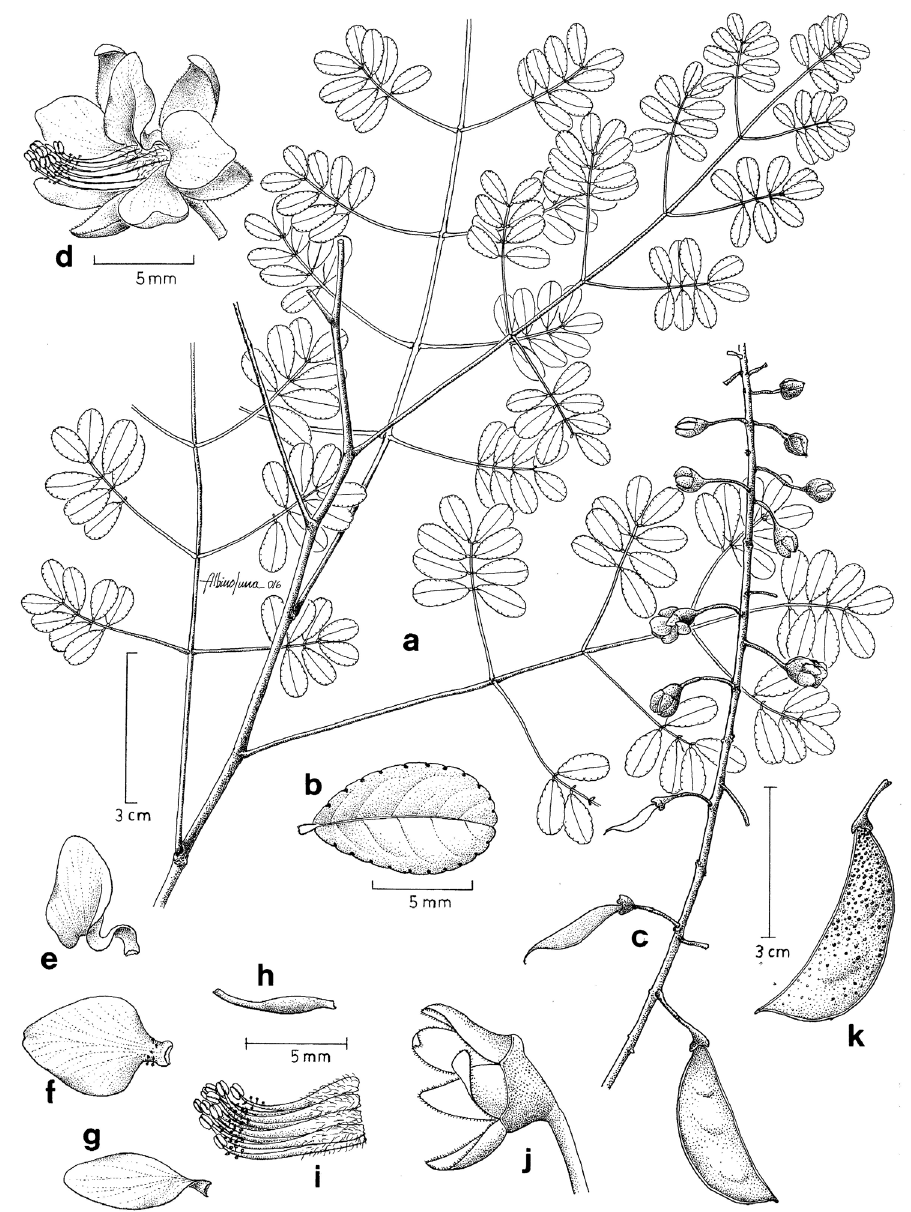
Figure 1. Erythrostemon guevarafeferii, a bipinnate leaves b leaflet upper surface showing marginal glands c inflorescence with immature fruits developing at base d flower e adaxial (median) petal f lateral petal g abaxial petal h gynoecium i stamens j calyx k fruit showing the red stipitate glands as black dots. ( a – j drawn from Contreras-Jiménez et al . 3111, holotype MEXU k from Contreras-Jiménez 2860). Drawn by Albino